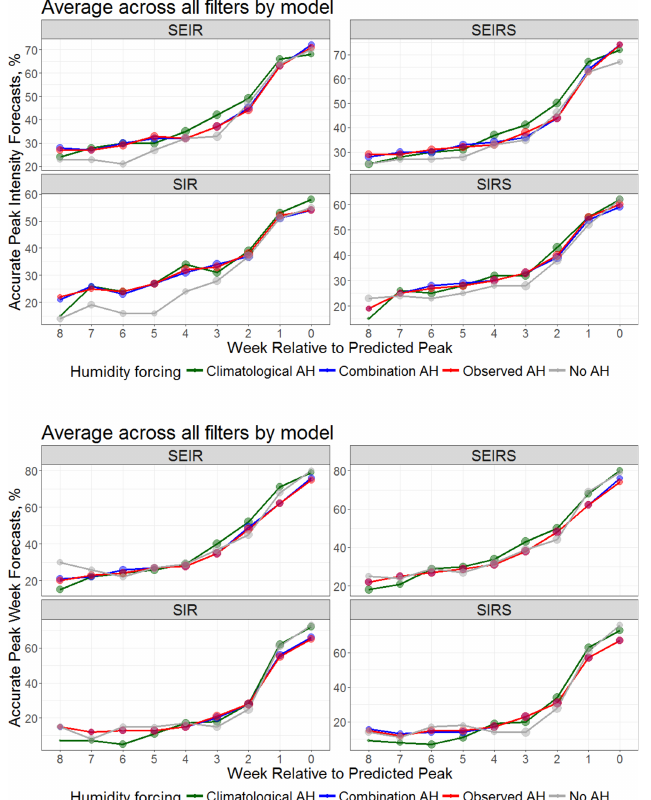
Fig 4. Percentage of forecasts accurate for predictions of peak intensity (top, within ± 25%of observed peak intensity) and peak timing (bottom, within ± 1 week of the observed peak) plotted as a function of forecastlead relative to the predicted peak for each of the 4 models forms (SEIR, SEIRS, SIR and SIRS). Shownare the forecast accuraciesfor models with climatological AH forcing (green), observedAH forcing (red), a combination of observed AH duringoptimizationand climatological AH during forecast (blue), and no AH forcing (grey). The numberof forecasts (log transformed) at each lead is represented by the size of the